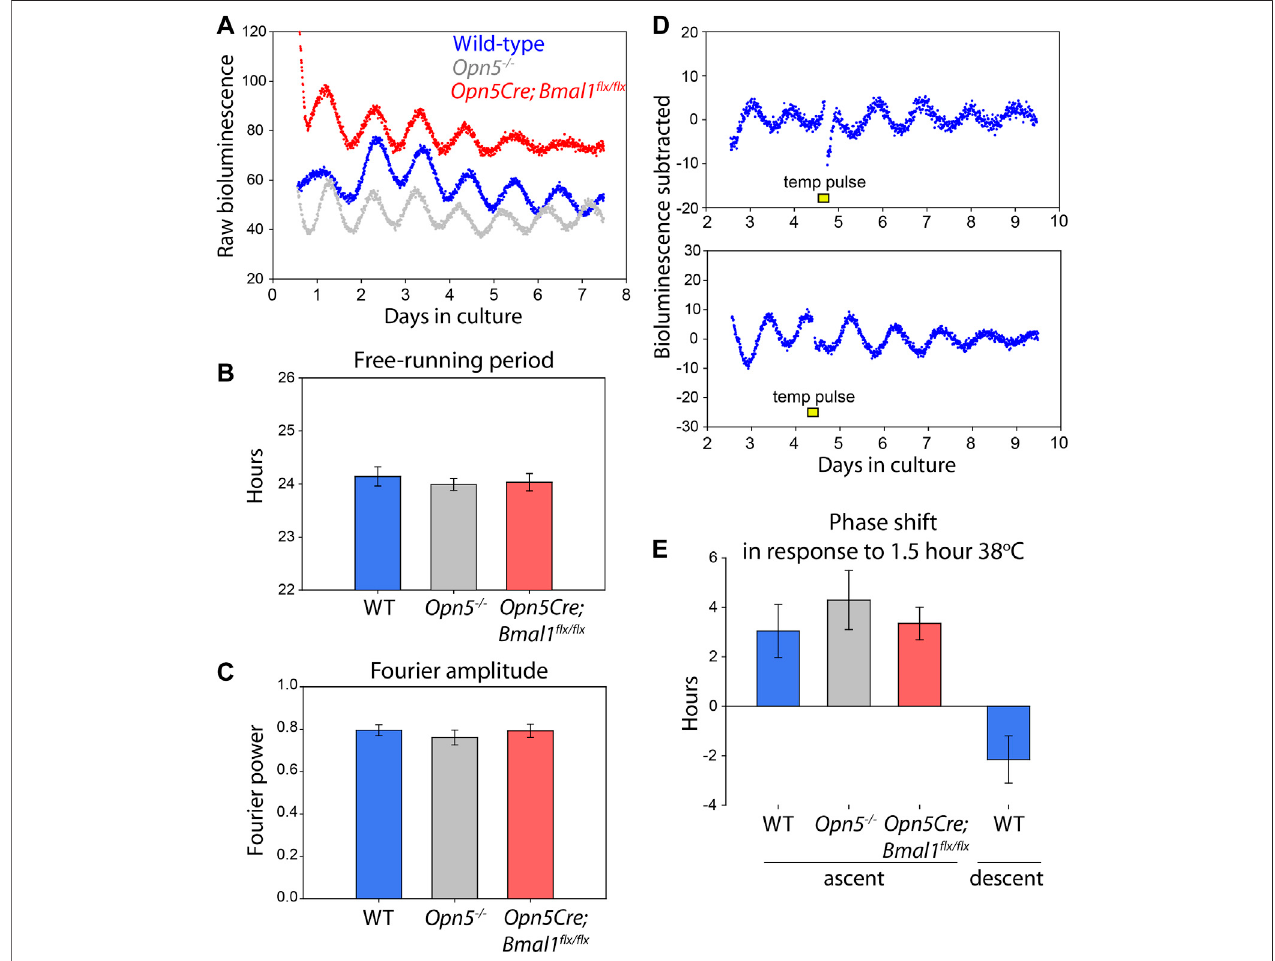
FIGURE 4 | Opn5, and rhythms of Opn5-cells, are not necessary for VMPO rhythmicity. (A) Bioluminescence traces of Per2 Luciferase from organotypic VMPO cultures from wild-type ( Per2 Luciferase , blue), Opn5 − / − ;Per2 Luciferase (gray), and Opn5-Bmal1-null ( Opn5 Cre ;Bmal1 fl x/ fl x ;Per2 Luciferase , red) mice. (B) Free-running period of 5 days of oscillations as measured by LMFit (Lumicycle Analysis). (C) Fourier power-spectrum amplitude strength between 20 and 30 h with a Blackman-Harris fi lter of thesameVMPOrhythmsas B (LumicycleAnalysis). n =8.Shownaremean±SEM.ANOVA, p > 0.05. (D) BioluminescencetracesofVMPOfrom Per2 Luciferase mice given90 min38 ° Ctemperaturepulses(fromabaselineof36 ° C)whereindicatedwithayellowbox. (E) Averagephasechange(comparingphaseofrhythmindays5 – 7to phase in days 1 – 4) after a temperature pulse occurring either in the early ascending phase ofthe luminescence rhythm (left, three genotypes) or early descending phase (right). Shown are mean ± SEM. n = 8, 5, 6, and 5, respectively.